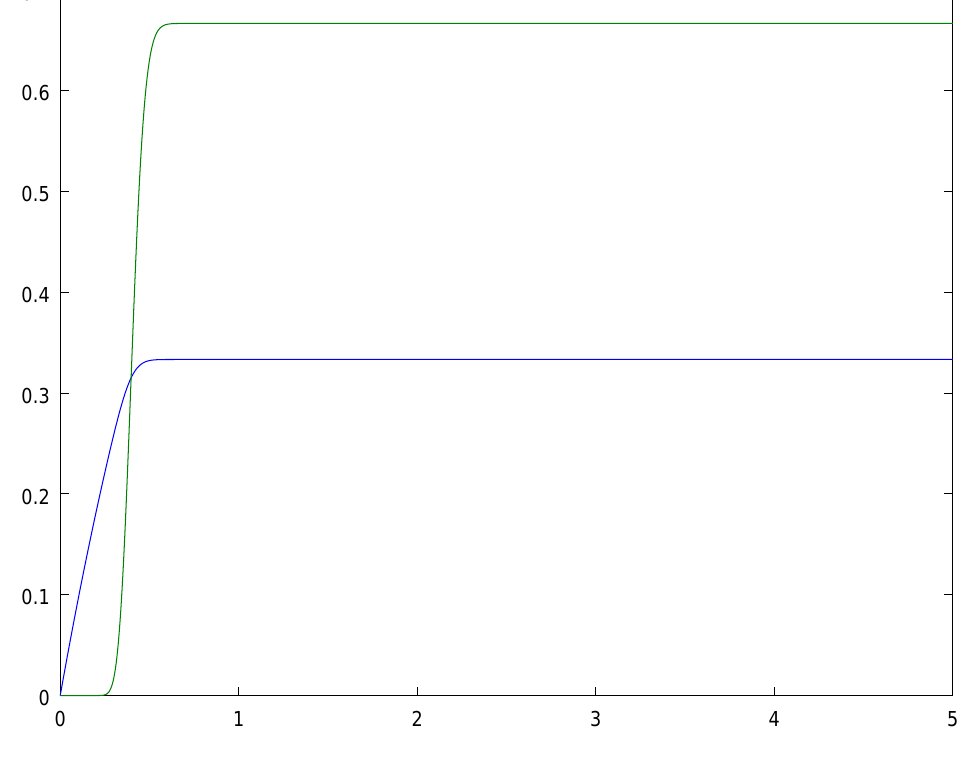
≈ q ( 5 ) ≈ 0.541801 and the following corresponding 0 0